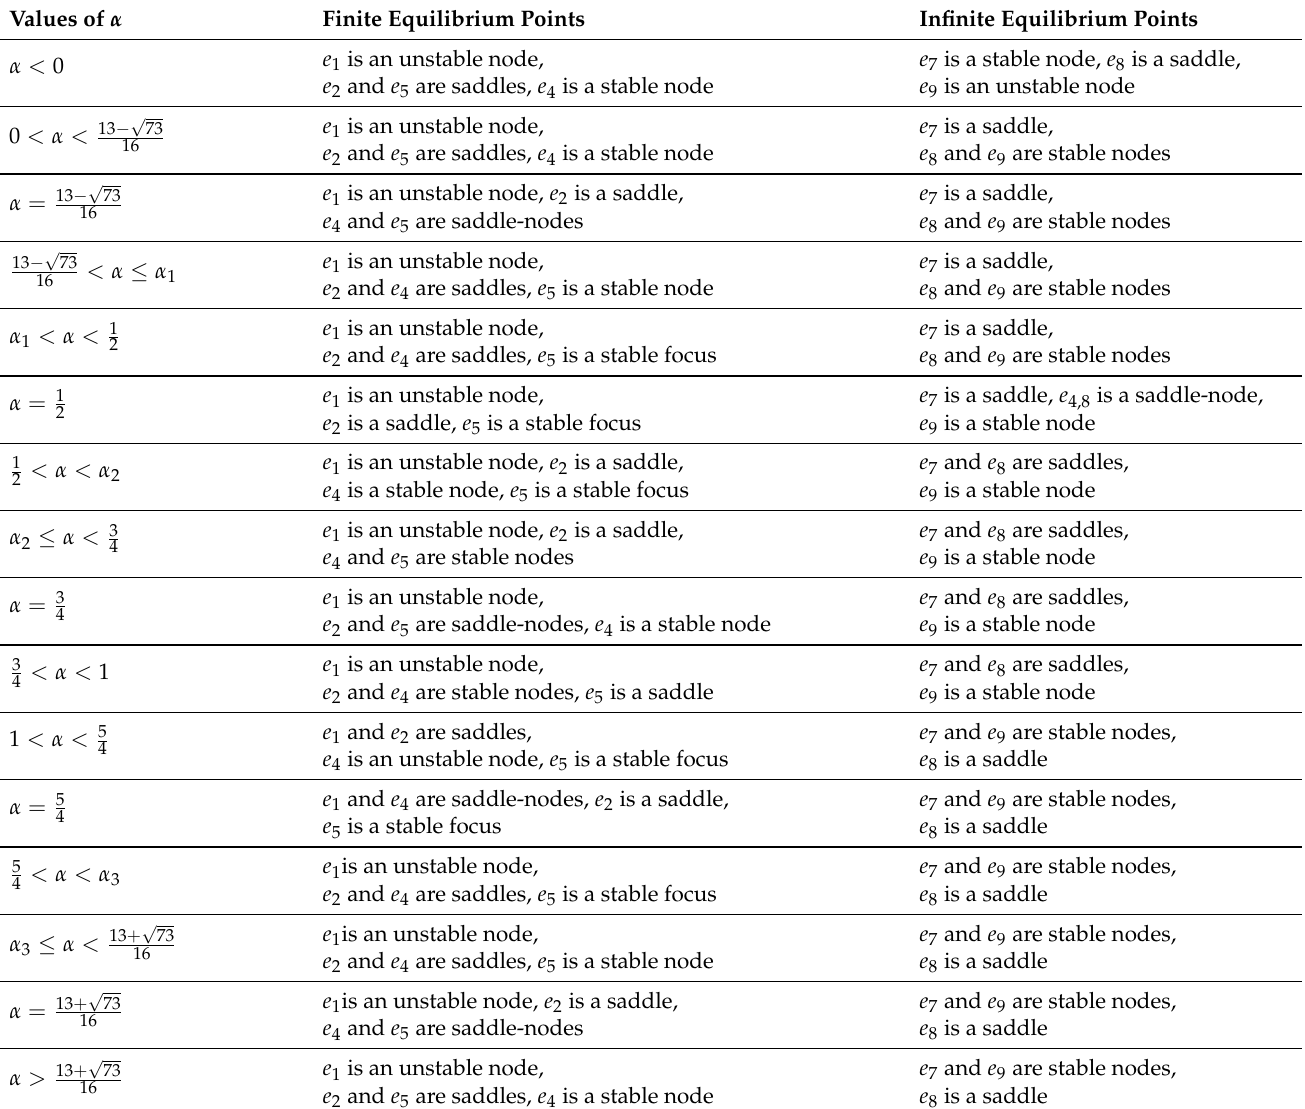
Table 3. Equilibrium points and their types corresponding to various α values of system